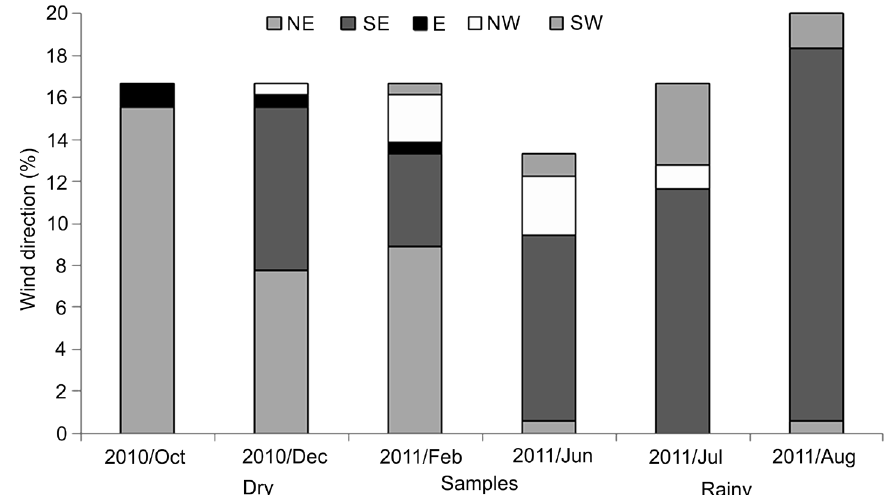
Figure 10. Frequency and direction of winds in each sampled month on the coast of Table 2. Analysis of variance tables comparing effects of rainfall and winds on species number, number of fishes, CPUE and mean length for fishes caught at the coast of Alagoas.